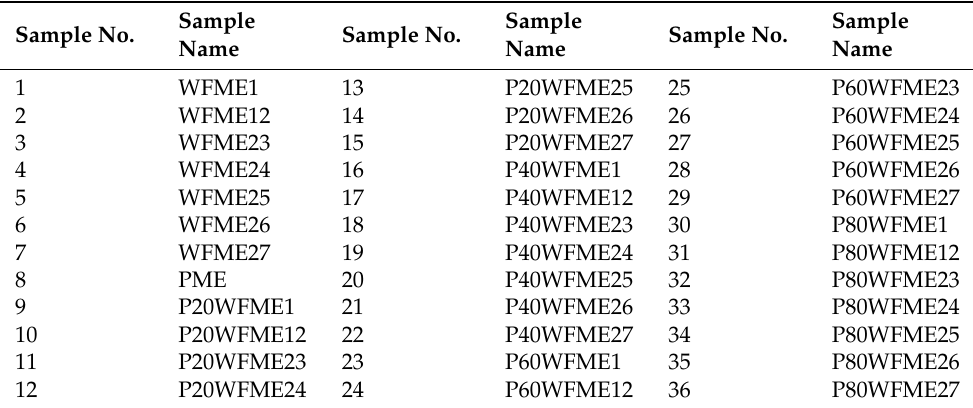
Table 10. List of samples used in this